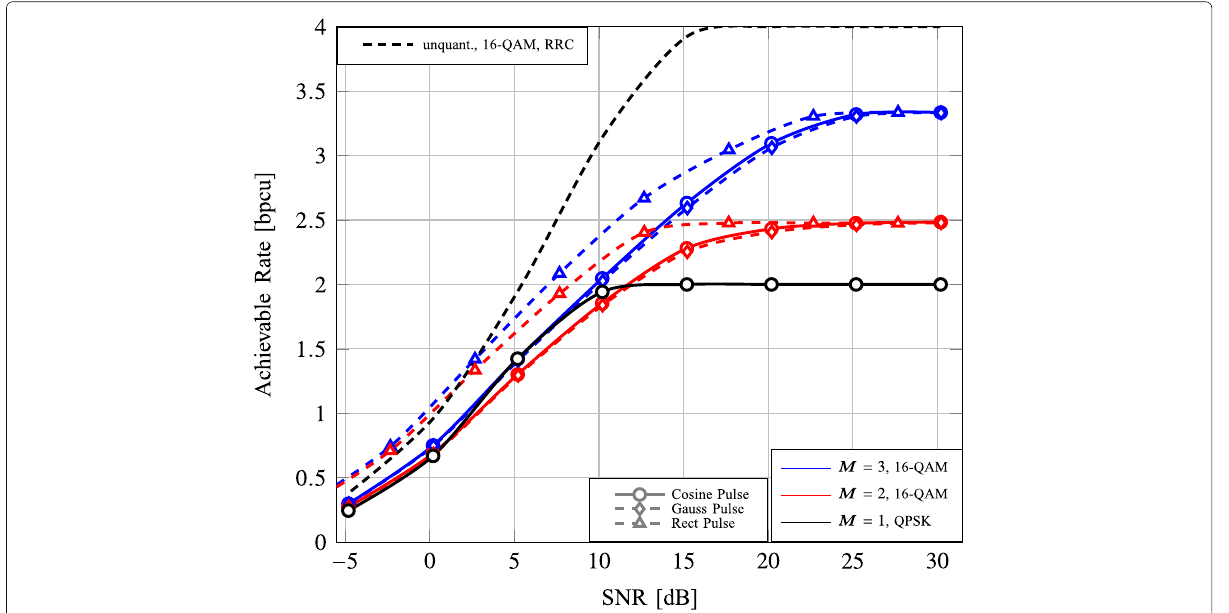
Fig. 5 The achievable rate for different transmit